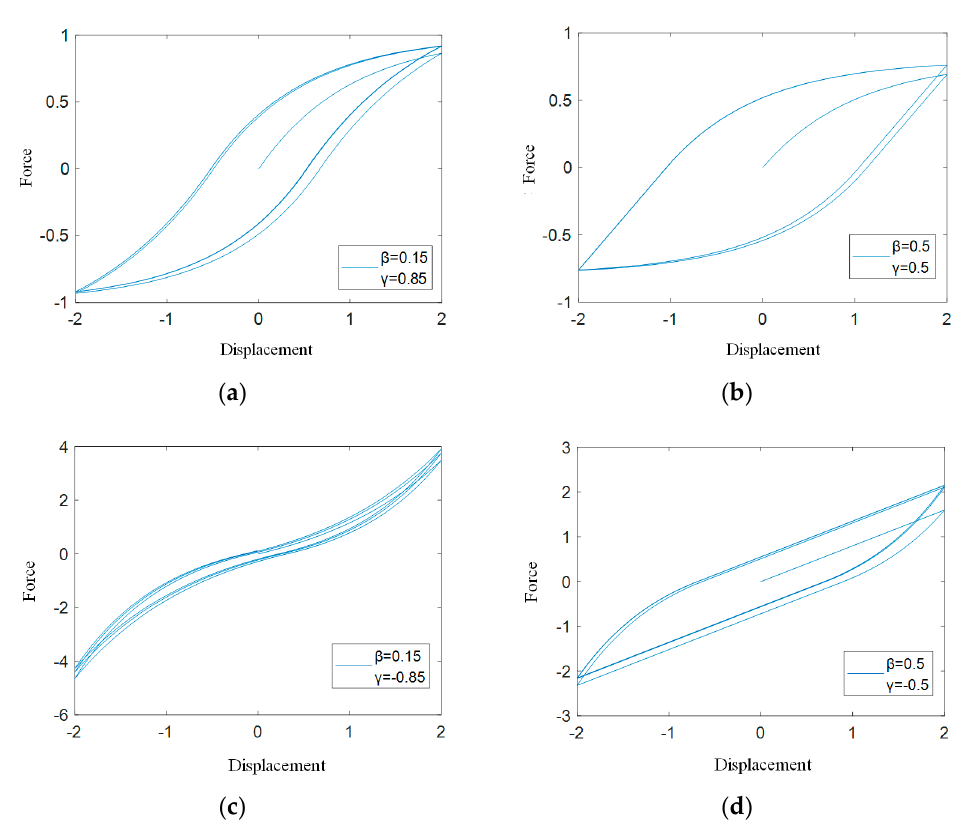
Figure 2. Bouc – Wen hysteresis loops with different parameters. (The values of β in ( a–d ) are 0.15, Figure 2. Bouc–Wen hysteresis loops with different parameters. (The values of β in ( a – d ) are 0.15, 0.5, 0.15, 0.5; The values 0.5, 0.15, 0.5; The values of γ in ( a–d ) are 0.85, 0.5, − 0.85, − 0.5.) of γ in ( a – d ) are 0.85, 0.5, − 0.85, −